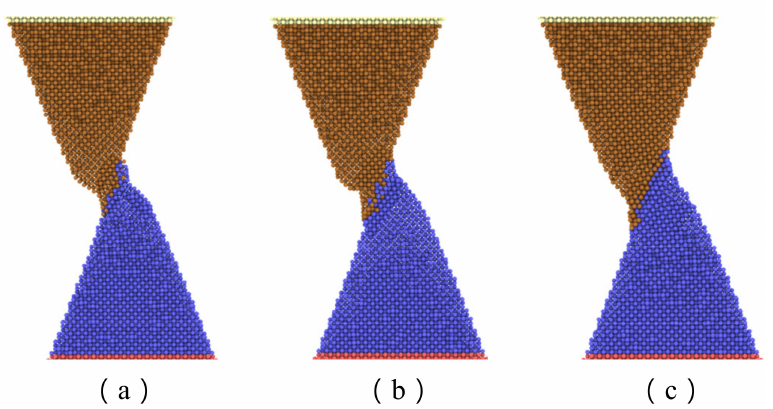
Figure 8. Snapshots of two copper cones forming a bonding interface with a separation distance of 20 Å and various contact lengths: ( a ) 15 Å; ( b ) 20 Å; ( c ) 25